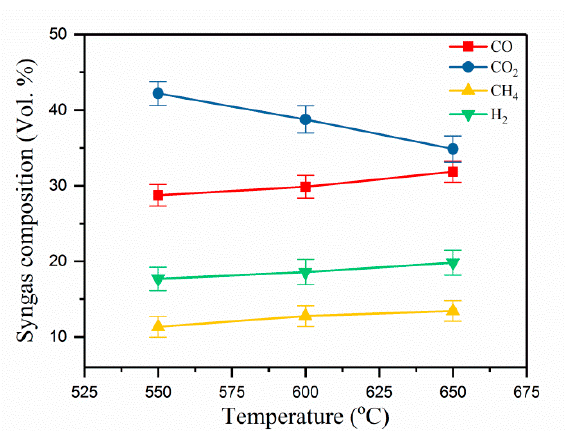
Figure 3. Effects of temperature on syngas composition during gasification. Figure 3. E ff ects of temperature on syngas composition during